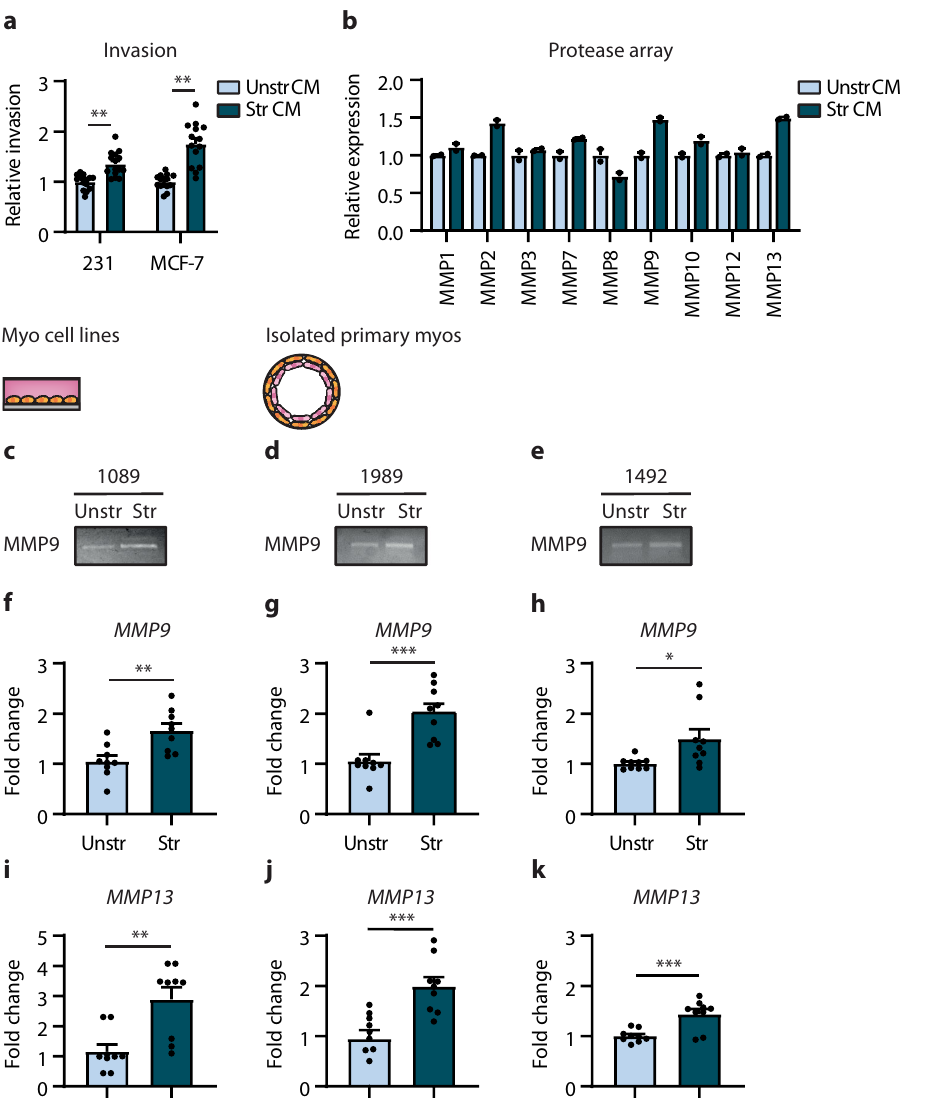
Cells were incubated with 10 μ g/mL TGF β RII-blocking antibody (R&D Systems) or IgG isotype control antibody (Merck Millipore, GC270) in serum-free media for 20 min at 4 °C on a rotating-wheel before plating. Functional assays were carried out 48 h postantibody treatment. Conditioned media Conditioned media (CM) was generated by culturing cells in serum-free media for 48 h. CM was concentrated 24-fold with centrifugal fi lters (Fisher) with 3 K molecular weight cut off (MWCO) at 4000 g for 45 min at 4 °C.